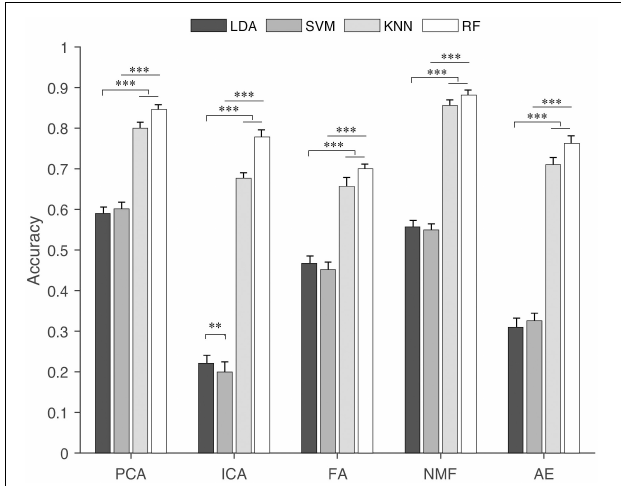
FIGURE 8 | Classification accuracy of different classification algorithms for each synergy extraction method. “ ∗∗ ” and “ ∗∗∗ ” indicate the significance levels are 0.01 and 0.001,